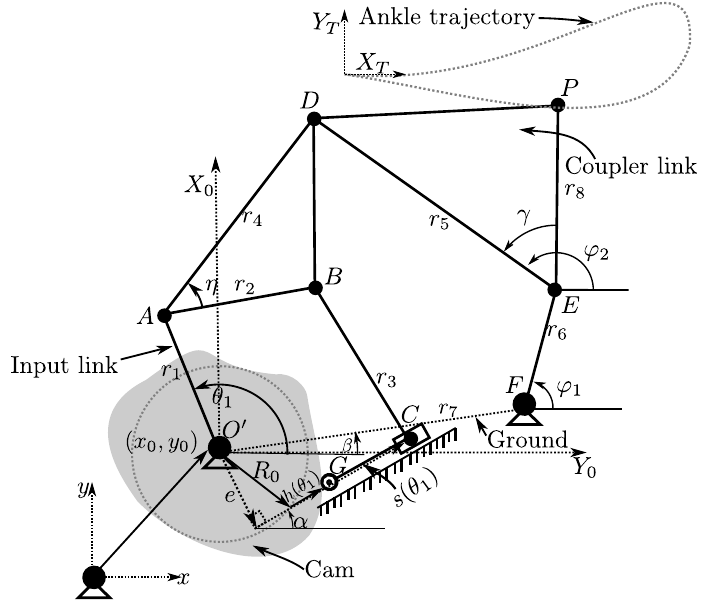
Figure 3. Cam-linkage